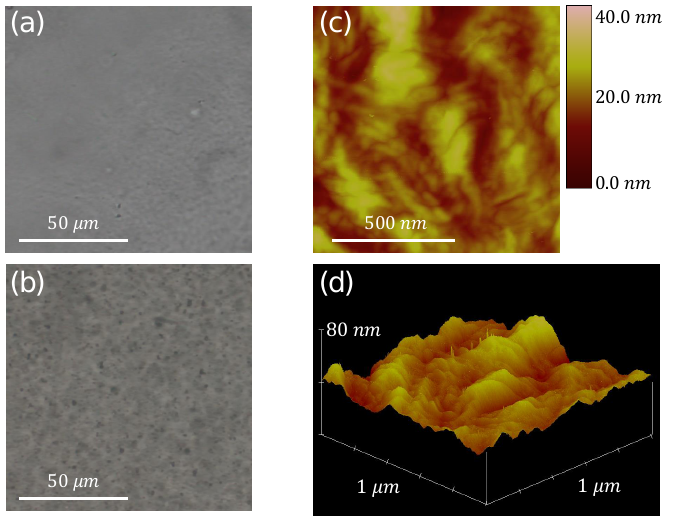
Figure 1. Optical microscope images of ( a ) neat LDPE and ( b ) the film containing ZnO (< 5 µ m). ( c ) AFM image with colorscale indicating z -coordinate values and ( d ) 3D plot of z -coordinate for a surface of size 1 × 1 µ m 2 , of the film containing ZnO (< 5 µ m).